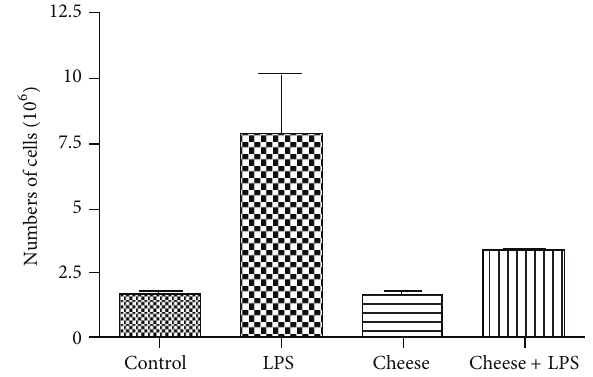
Figure 2: Peritoneal cell count in LPS-stimulated mice fed with Roquefort cheese. Mice were gavaged twice (once daily) with PBS containing 10.0mg of blue-veined cheese or PBS alone (control). 24 hours later, the animals were injected intraperitoneally with LPS or its solvent (PBS). Peritoneal washes were obtained 48 hours after LPS injection and the resulting cell suspensions were counted as described in Section 2.